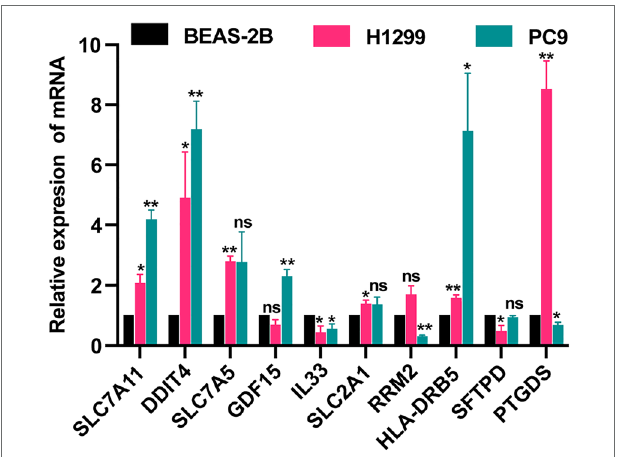
FIGURE 8 | Validation of expression of FRGs and IRGs by qRT-PCR. * p < 0.05 and ** p <